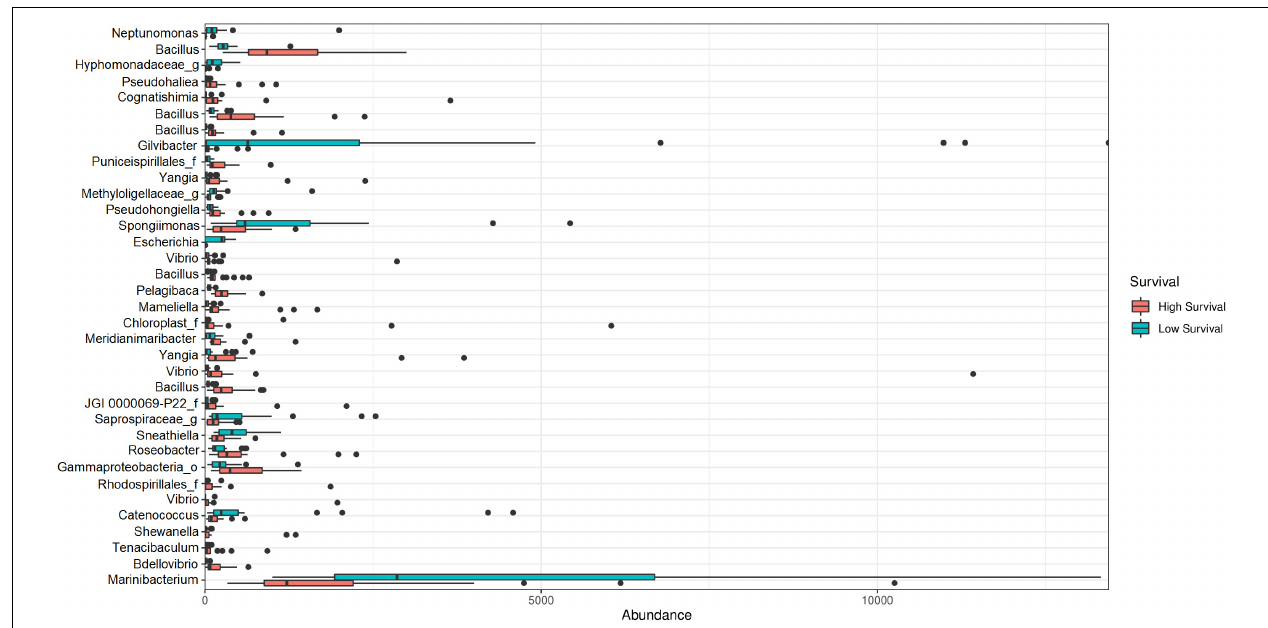
FIGURE 7 | Absolute abundance of ASV biomarkers at the genus level at the high- and low-survival tanks affected with